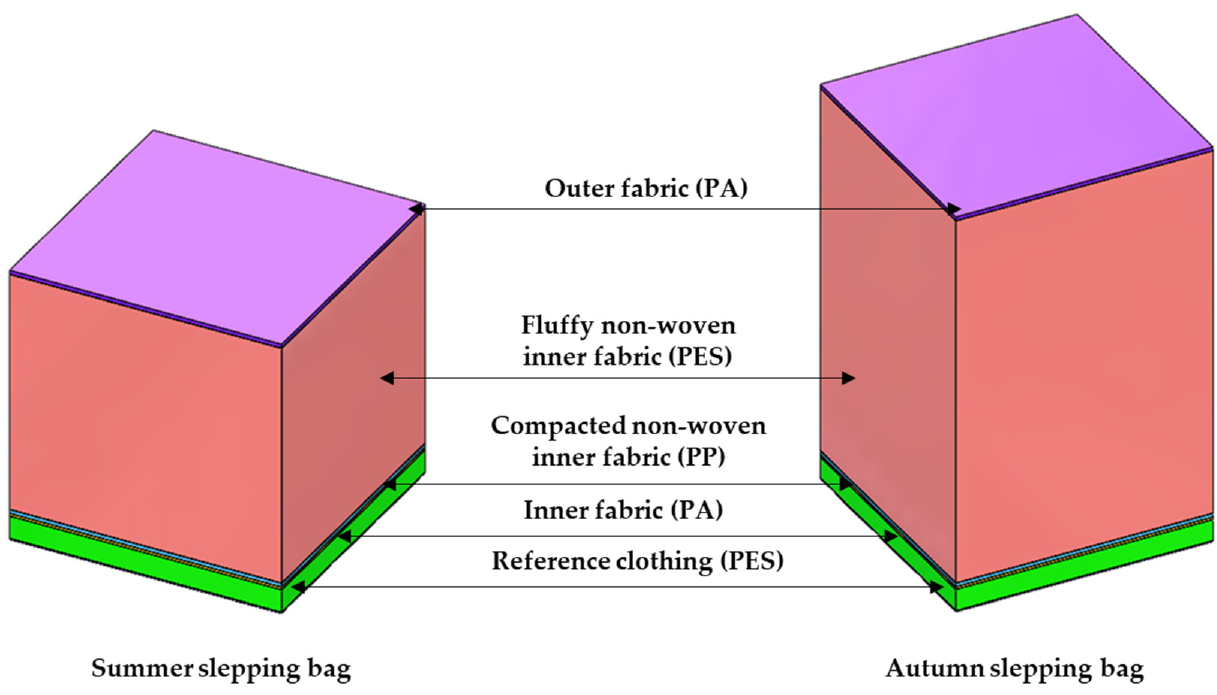
Figure 1. 3D models of sleeping bags.